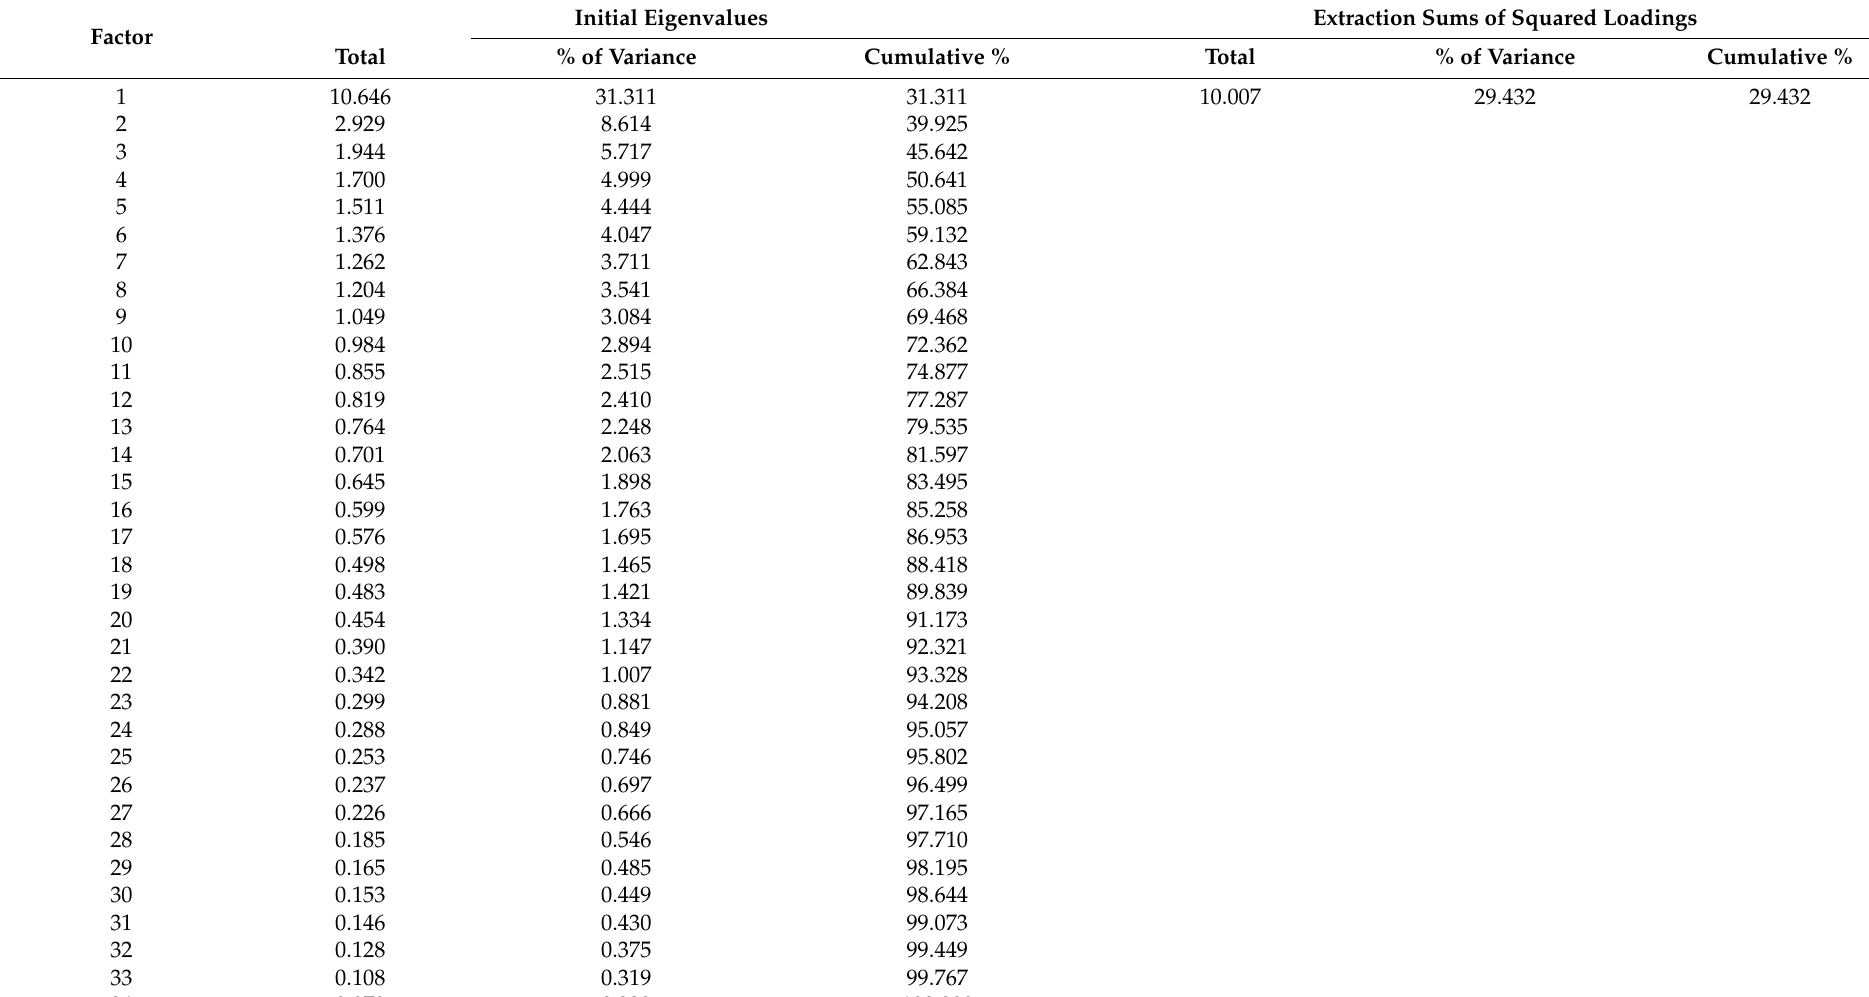
Table A3. Total variance explained (Harman’s Single Factor